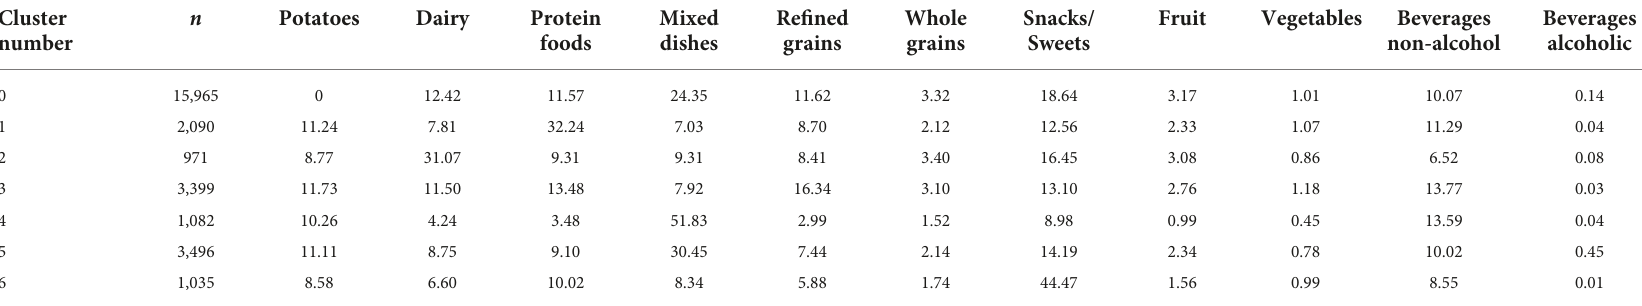
n Potatoes Dairy Protein